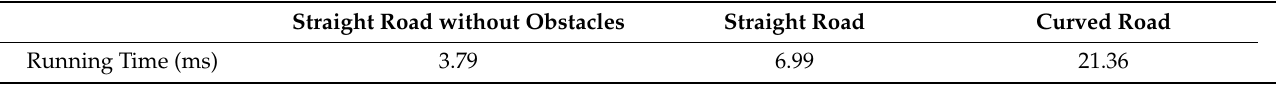
Table 2. Performance measure for real time; state of k 1 = 0.5, k 2 = 0.3, length 100 m, and nObstacles 400. Straight Road without Obstacles